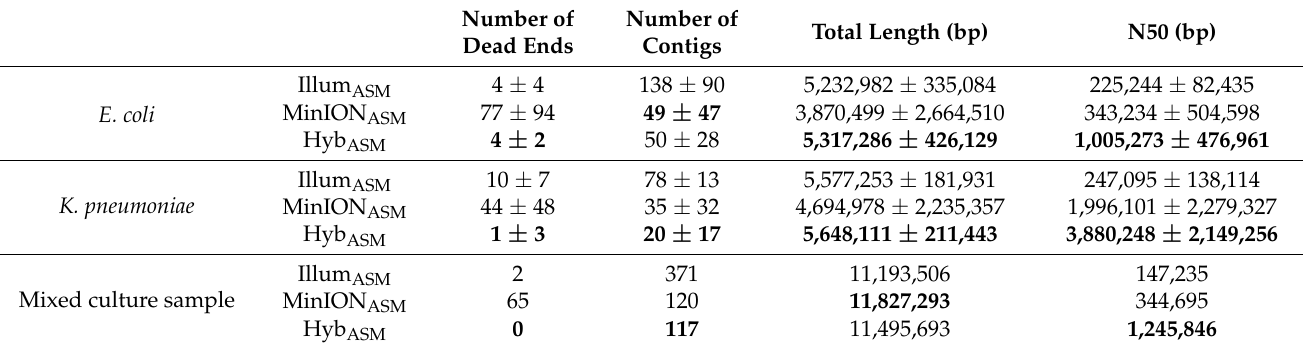
Table 2. An overview of statistics for different E. coli and K. pneumoniae assemblies produced by the top-performing assemblers. Illum ASM was produced using Unicycler, MinION ASM using Flye and Hyb ASM created using Unicycler. The top values are highlighted in bold. The mixed culture was obtained from the co-culturing of E. coli 4 and K. pneumoniae 5 isolates. Numbers show the average ±